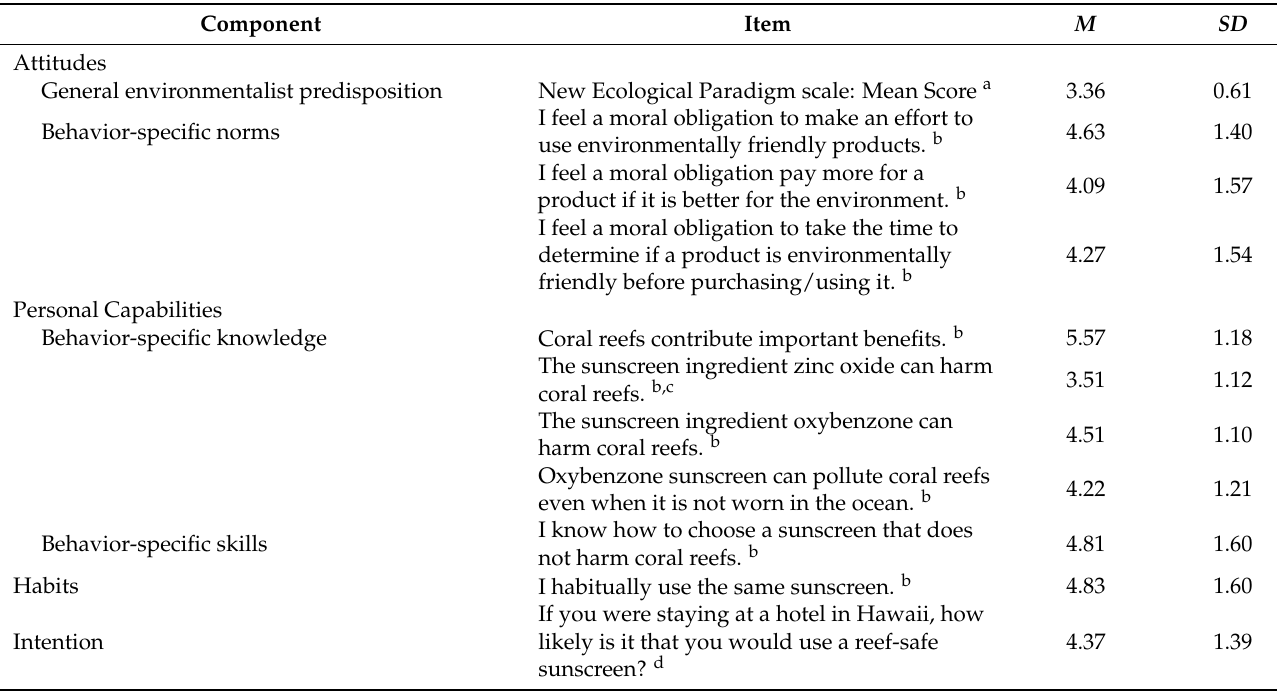
Table 4. Description of Attitudes, Personal Capabilities, Habits, and